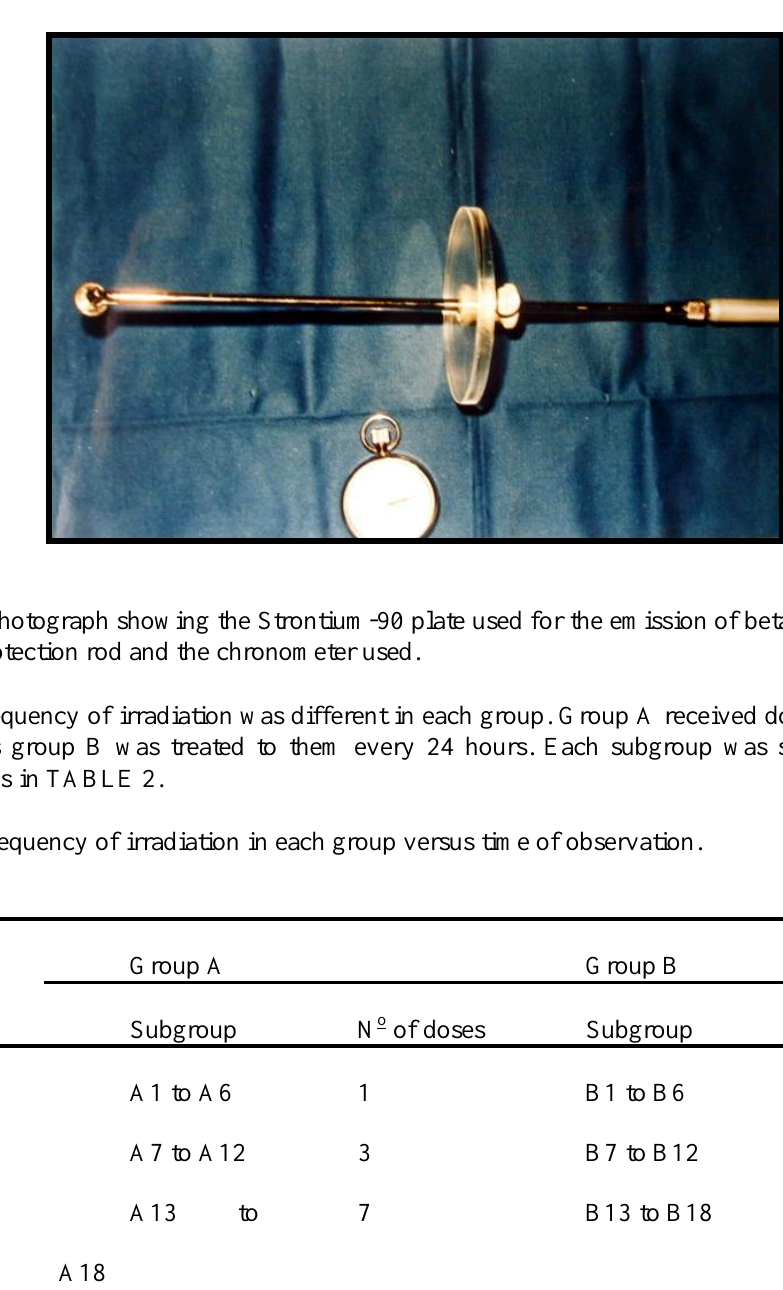
Time of Group A Group